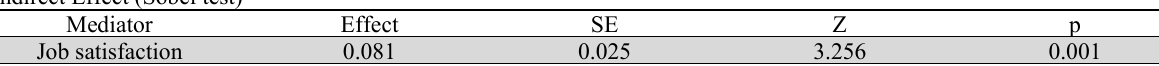
Organizational commitment